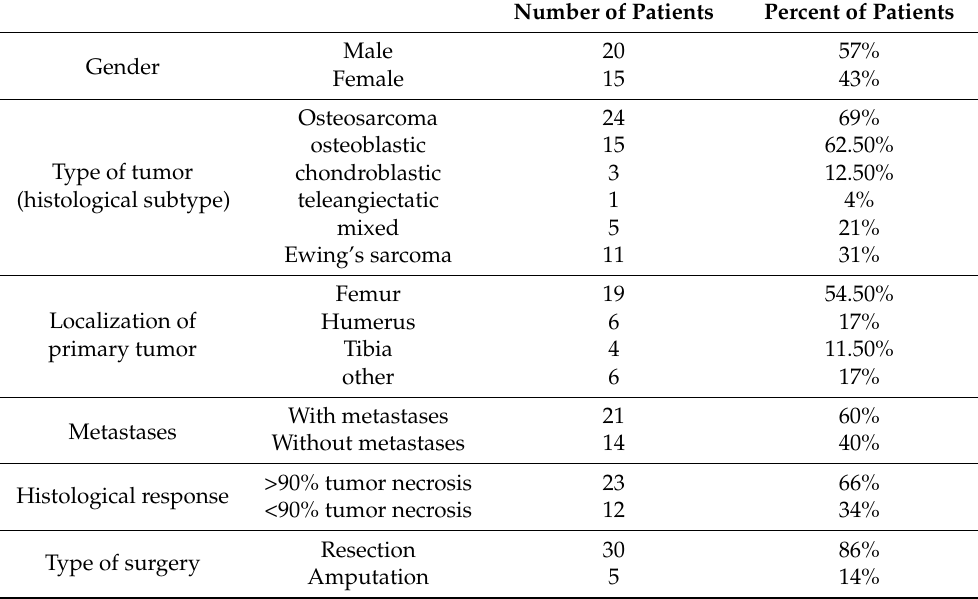
Table 1. Clinical characteristics of patients with malignant bone